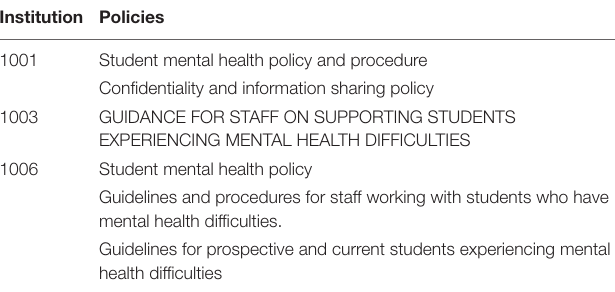
TABLE 3 | Institutions and cause for wellbeing concern